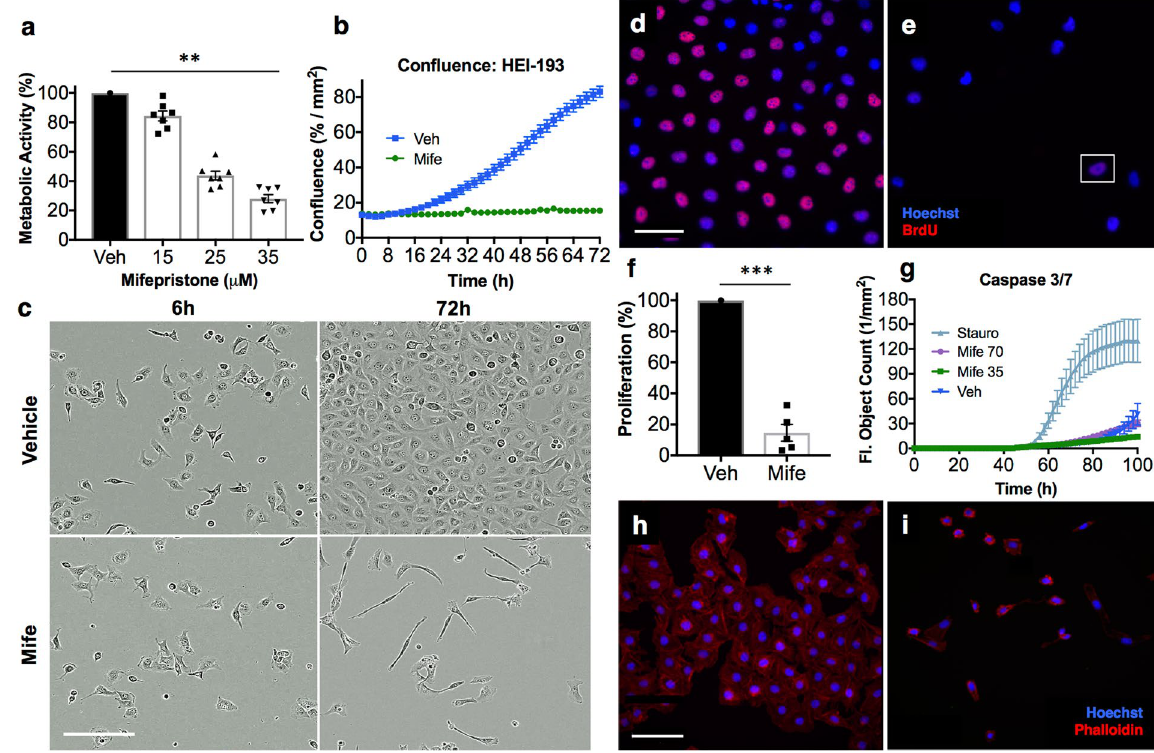
Figure 2. Mifepristone adversely affects HEI-193 cells in culture. ( a ) Metabolic viability of HEI-193 cells decreases with increasing concentration of mifepristone after 72 h in culture. Individual data points represent metabolic activity as percentage of vehicle-treated control for seven independent experiments, performed in replicates of 3–5 wells per condition (vehicle-treated cells versus 35 μ M mifepristone-treated cells, p = 0.006; ** p < 0.01). ( b ) Phase object confluence remains constant among cells treated for 72 hours with 35 μ M mifepristone, while vehicle-treated cells exhibit normal proliferation. Error bars in the mifepristone-treated condition are smaller than the size of the symbol. ( c ) 10X phase contrast images of vehicle-treated cells (top row) and cells treated with 35 μ M mifepristone (bottom row) 6 h and 72 h post-treatment. ( d – f ) The percentage of BrdU + HEI-193 cells significantly declines after 72 h treatment with mifepristone (p = 0.0007; *** p < 0.001): ( d ) 25X epifluorescence image of cells treated with 0.1% DMSO vehicle, with BrdU in red and Hoechst stain in blue; ( e ) Cells treated with 35 μ M mifepristone, where the white box encloses a single BrdU + cell; ( f ) Quantification of five replicate experiments. ( g ) Activation of fluorescent caspase 3/7 detected via live-cell imaging over 100 h of mifepristone treatment reveals a slight but not significant elevation in caspase 3/7 activity between mifepristone-treated cells (70 μ M and 35 μ M) and vehicle-treated control cells; positive control is staurosporine (0.5 μ M) and drug is applied 48 h after plating. Note that after 96 h in culture, normally proliferating vehicle-treated cells become overly confluent and begin to apoptose. ( h – i ) Phalloidin staining of mifepristone-treated cells reveals crumpled f-actin morphology after 72 h: ( h ) Cells treated with 0.1% DMSO vehicle; ( i ) Cells treated with 35 μ M mifepristone, where rhodamine phalloidin is red and Hoechst stain is blue. Center values in histograms are means; error bars are